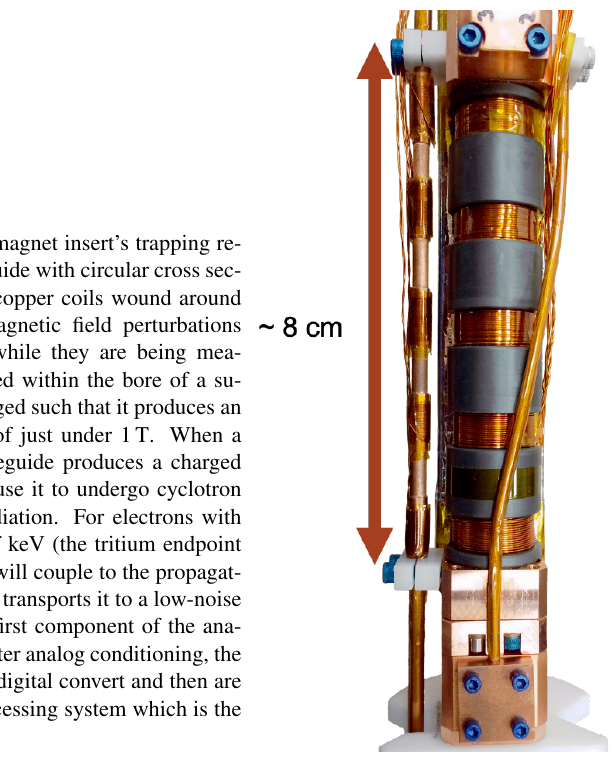
Figure 1. The Project 8 Phase II magnet insert’s trapping re- gion, the core of which is a waveguide with circular cross sec- tion. There are five independent copper coils wound around the waveguide which provide magnetic field perturbations which axially confine electrons while they are being mea- sured. The entire insert is installed within the bore of a su- perconducting NMR magnet, charged such that it produces an axial background magnetic field of just under 1T. When a radioactive decay within the waveguide produces a charged particle, the ambient field will cause it to undergo cyclotron motion and produce cyclotron radiation. For electrons with kinetic energies in the low tens of keV (the tritium endpoint is around 18 . 6keV, this radiation will couple to the propagat- ing mode of the waveguide, which transports it to a low-noise cryogenic amplifier which is the first component of the ana- log signal conditioning system. After analog conditioning, the signals are passed to an analog to digital convert and then are processed in the digital signal processing system which is the subject of this